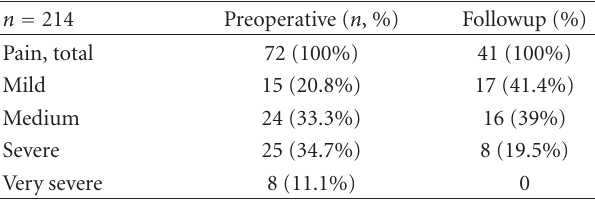
Table 3: Lower abdominal pain, preoperative and